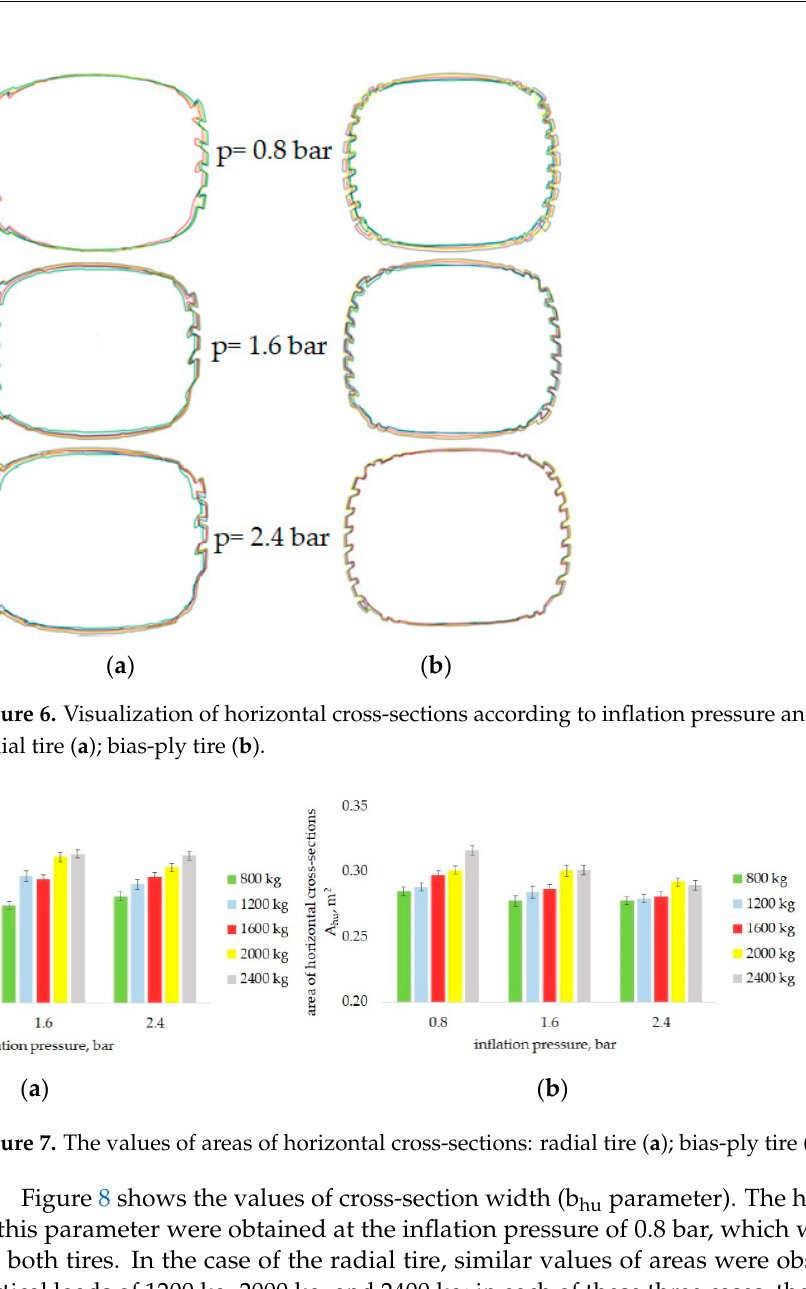
Figure 7. The values of areas of horizontal cross-sections: radial tire ( a ); bias-ply tire ( b ).